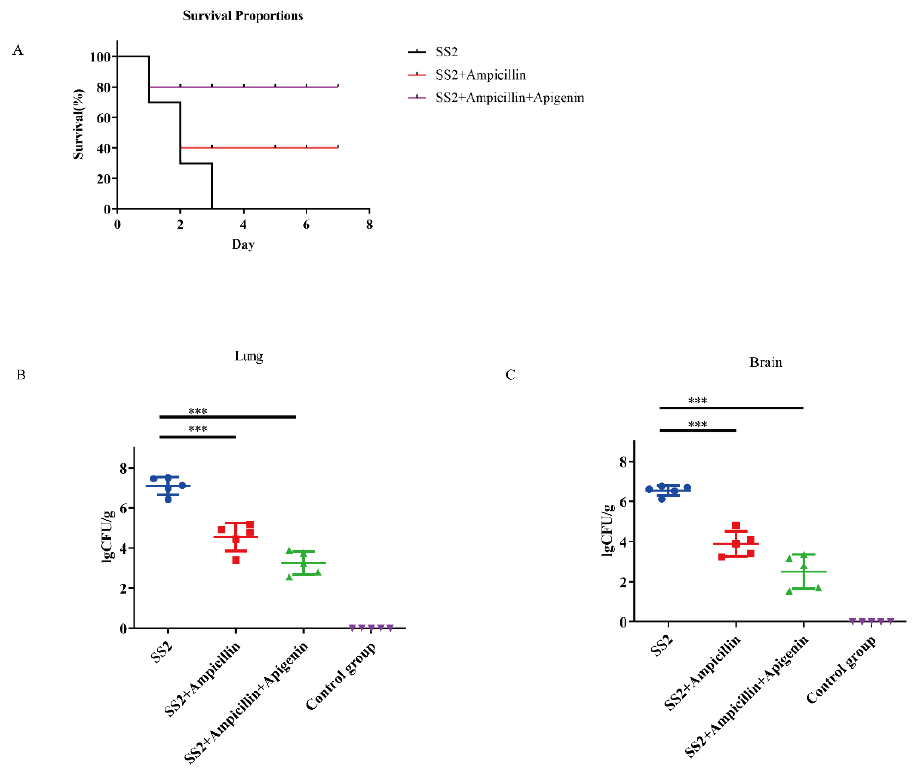
Figure 5. ( A ) The survival rates of apigenin + ampicillin and ampicillin cured a severely infected mice model. Bacterial burdens in the livers and spleens of the infected mice. Mice were intraperitoneally inoculated with 5 × 10 8 CFU/mL of SC19. Bacterium number in the lung ( B ) and spleen ( C ) was counted at 8 h post-infection (two-tailed, unpaired t -tests, n = 5). *** p < 0.001.